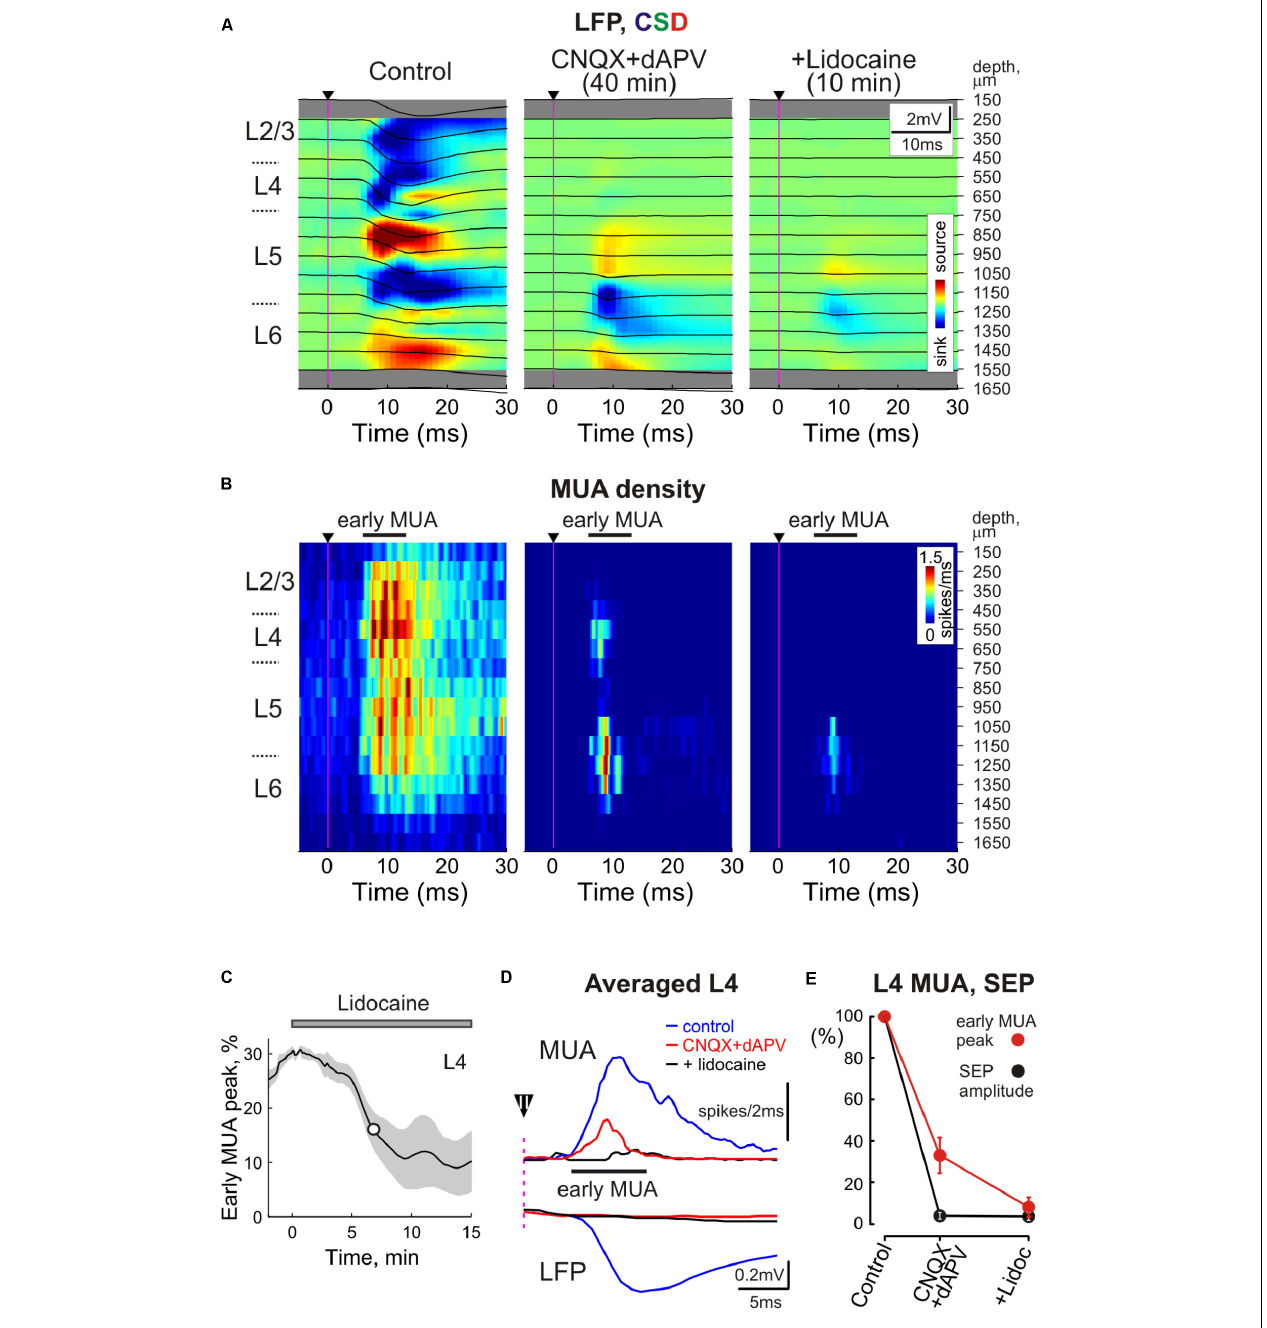
FIGURE 3 | Sensory evoked activity resistant to ionotropic glutamate receptor antagonists in the thalamorecipient cortical layers. (A) Top , Stimulus-triggered LFP averages ( n = 30 responses; black traces) of sensory responses evoked by principal whisker deflection across cortical depths of the corresponding barrel column overlaid on color-coded current source density plot (CSD) in control, 40 min after 500 µ M CNQX and 2 mM dAPV application, and 10 min after consecutive 2% lidocaine application. (B) Corresponding stimulus-triggered averages for MUA ( n = 30 responses). Stimulus onset on (A,B) is indicated by the black arrowhead and vertical magenta line. The cortical layer borders are shown left of the CSD and MUA density plots, and recording electrode depths are shown on the right. (C) The time course of early evoked L4 MUA suppression by 2% lidocaine epipially applied (gray bar above the plot) after the full blockade of SEP by CNQX/dAPV. The shaded area around the curve show SE bands ( n = 4 animals). The white circle on the curve indicates a half-maximal effect time (T 1 / 2 ). (D) Averaged L4 LFP and MUA in control, in the presence of CNQX and dAPV, and after lidocaine application. Before averaging, individual LFP and MUA curves were aligned by the onset of SEP. Black arrowhead with an error bar above the dashed magenta line shows a mean time with SE between the stimulus and SEP onset. (E) Normalized mean values of SEP amplitude and early MUA peak in cortical L4 in control, in the presence of CNQX and dAPV, and after lidocaine application. (D,E) Show averaged data from 11 animals and two concentrations, 170 µ M CNQX/700 µ M dAPV and 0.5 mM CNQX/2 mM